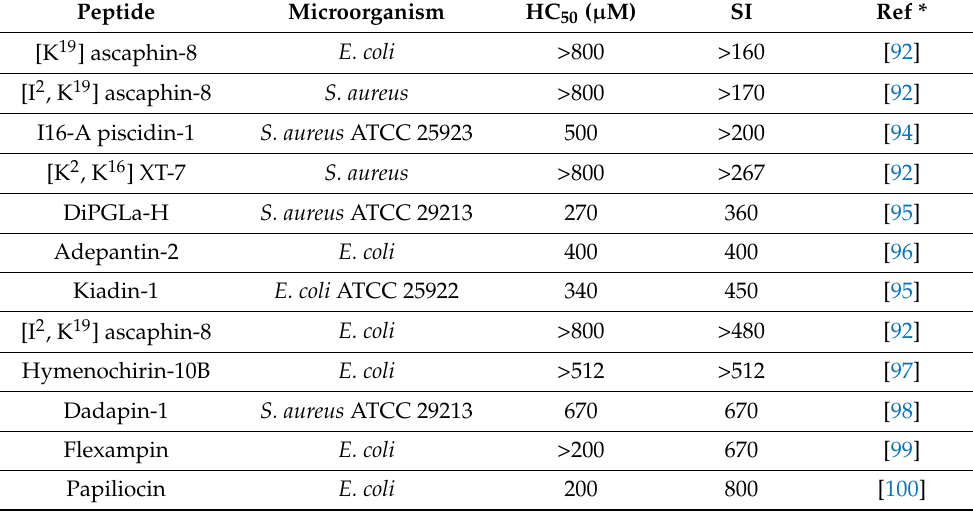
Table 1. Hemolytic activity and selectivity indices for reference antimicrobial peptides. A promising peptide drug candidate must combine low or no toxicity and high biological activity. Examples include highly active peptides evaluated against Staphylococcus aureus and Escherichia coli .